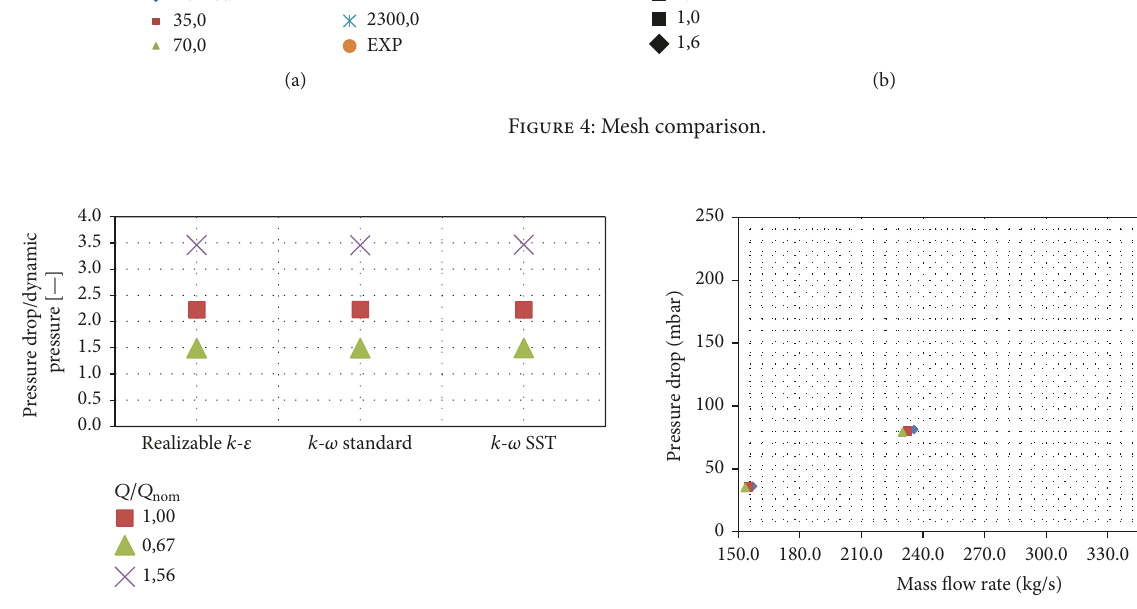
Figure 5: Comparison between different turbulence models and experimental results.